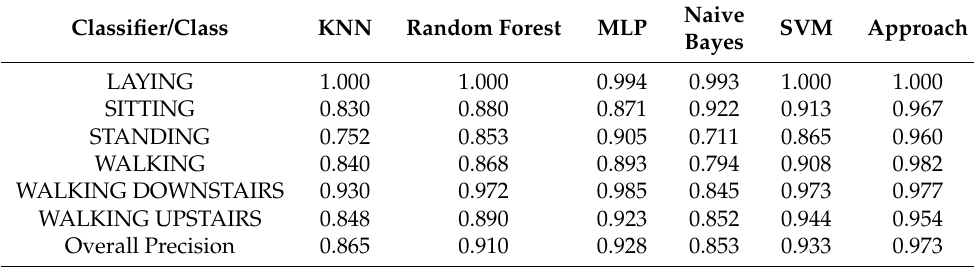
Table 3. Detailed Precision by